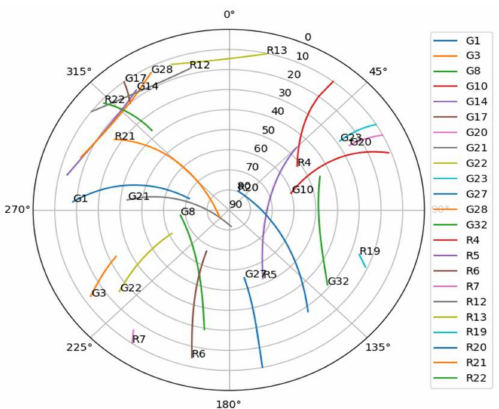
Figure 7. Diagram of satellite movement above the inspection vehicle on the optimal route. It is the azimuth and elevation plot. The satellite ID is located at the point where the satellite started to be